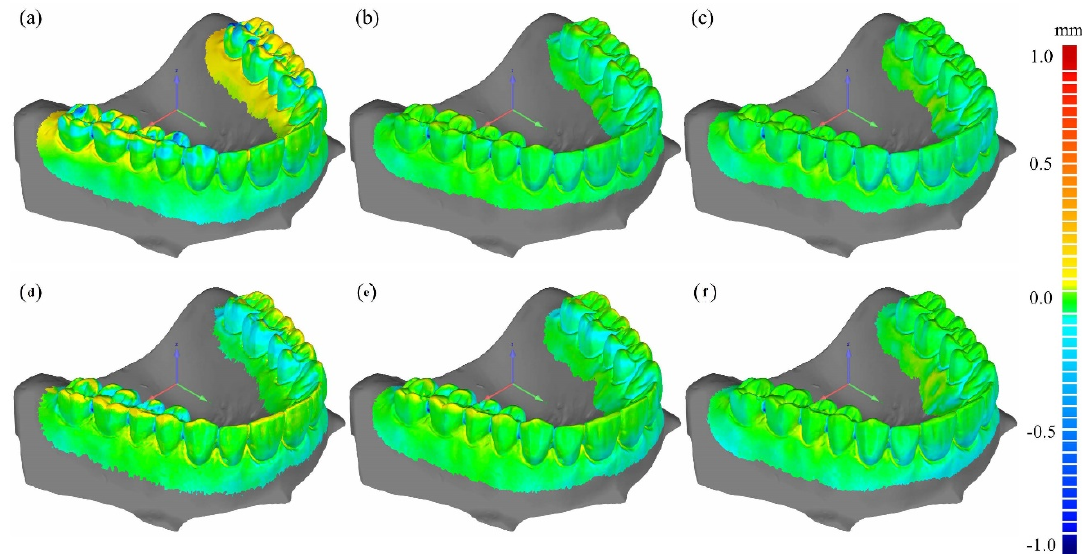
Figure 8. The deviation maps of Model 1 as compared to the optical STL (reference). ( a – c ) show deviation maps computed from the FDK images taken at the cone-beam angles of 10, 5, and 0 degrees, respectively, while ( d – f ) show deviation maps computed from the CW-FDK images taken at the cone-beam angles of 10, 5, and 0 degrees, respectively.